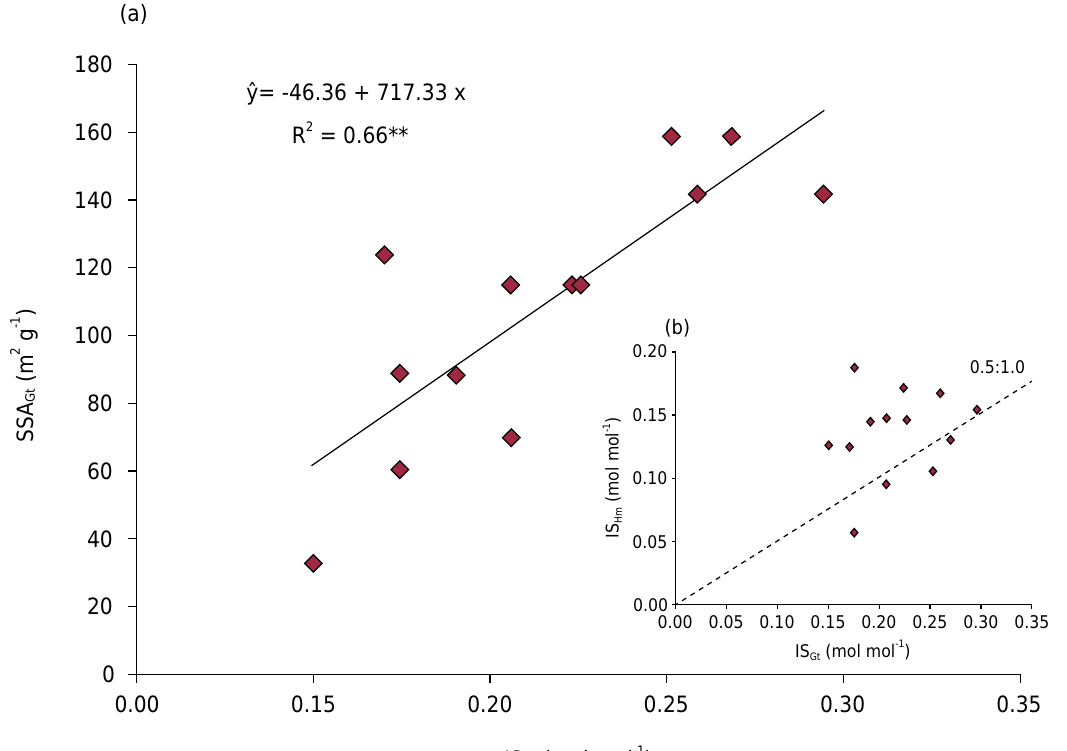
0.000 Figure 4. Relationship between specific surface area (SSA) and isomorphic substitution of Fe by Al (IS) values in Gt (a); and relationship between IS values in Hm and Gt (b). ** : significant at 1 %.